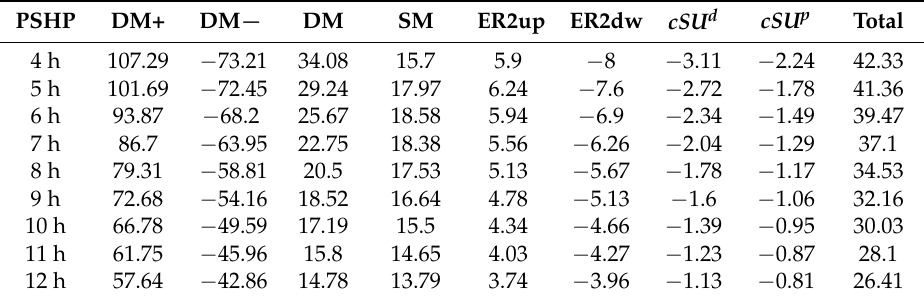
Table 4. Annual incomes and costs, expressed in M € , obtained by all the PSHPs in each market and service with the SRS D + 1 strategy.